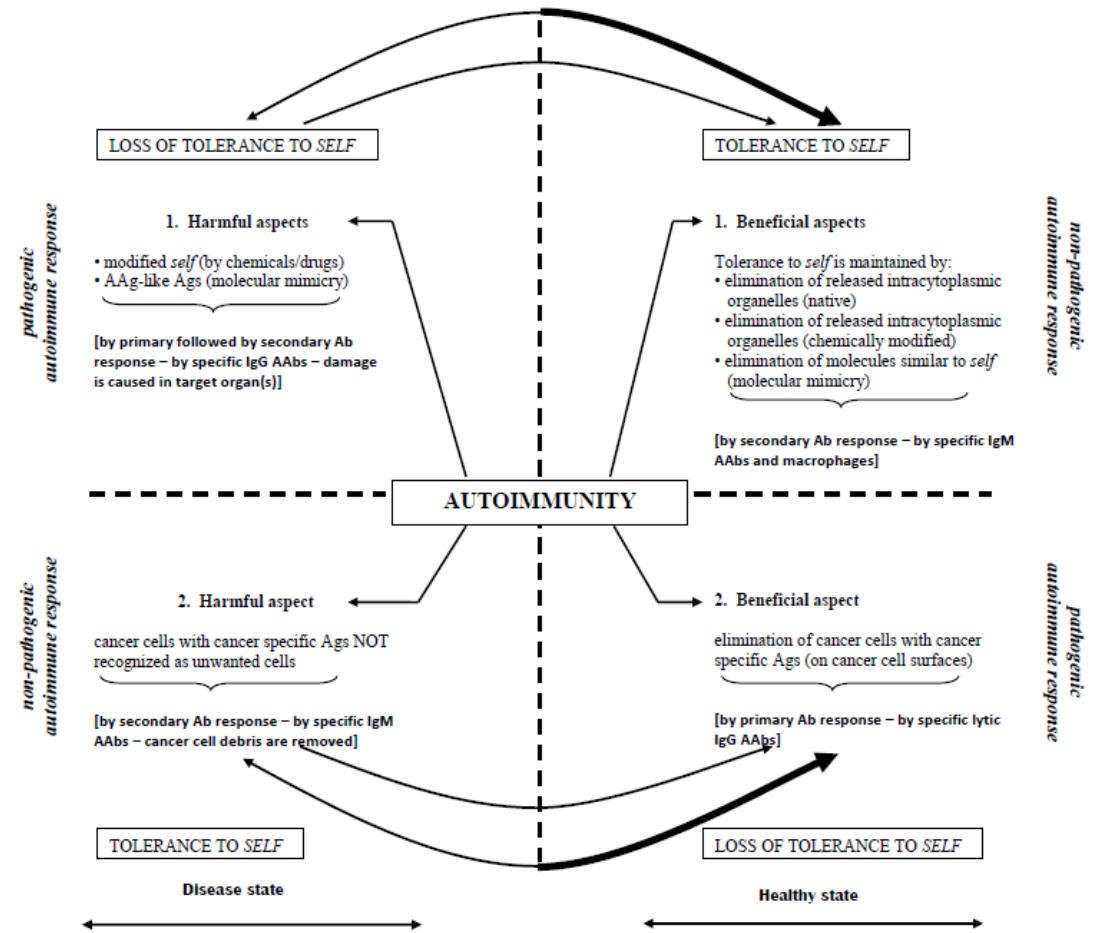
Figure 1. Induction of autoimmunity represented by beneficial and harmful immune responses against self. Regaining tolerance to self in both autoimmune diseases and cancer by the removal of intracytoplasmic components and elimination of cancer cells with cancer-specific antigens, respectively. (Figure reproduced by permission from BioProcessing Journal , 2007 Winter, 6(4), 12 – 18). Abbreviations: AAg, autoantigen; AAbs, autoantibodies; Ab, antibody; Ag, antigen; IgG, immunoglobulin G; IgM, immunoglobulin M; MVT, modified vaccination technique.